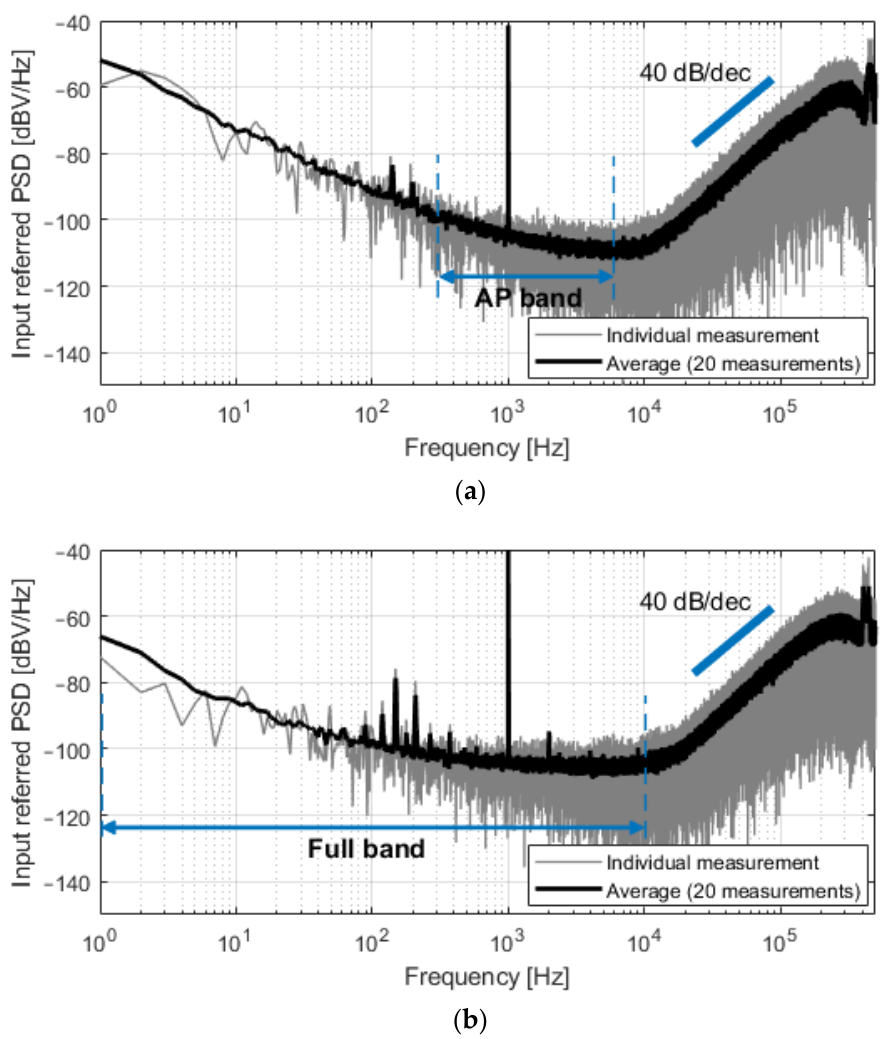
Figure 8. Spectra of the measured output bitstreams, referred at the input of the converter, for a sinus- oidal input of 200 μ V p at 1 kHz. ( a ) For C 0 = 350 fF, the input-referred noise in the 300 Hz–6 kHz band was 5.0 μ V rms ; ( b ) For C 0 = 4.25 pF, the input-referred noise in the 1 Hz–10 kHz band was 8.7 μ V rms .